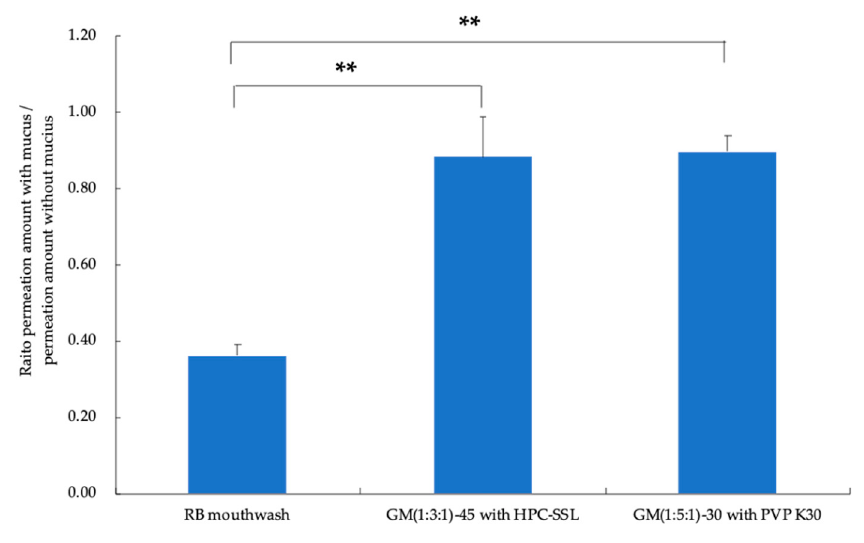
Values are shown as mean ± SD ( n = 3). ** p < 0.01 vs. RB mouthwash. Figure 6. Mucus permeation evaluation of RB mouthwash, GM (1:3:1)-45 with HPC-SSL, and GM (1:5:1)-30 with PVP K30.